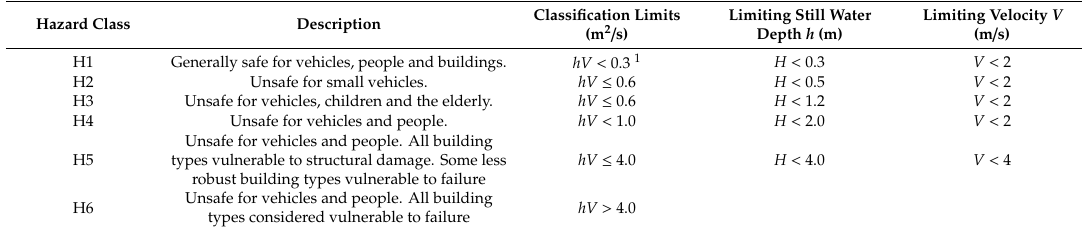
Table 1. AIDR table for hazard